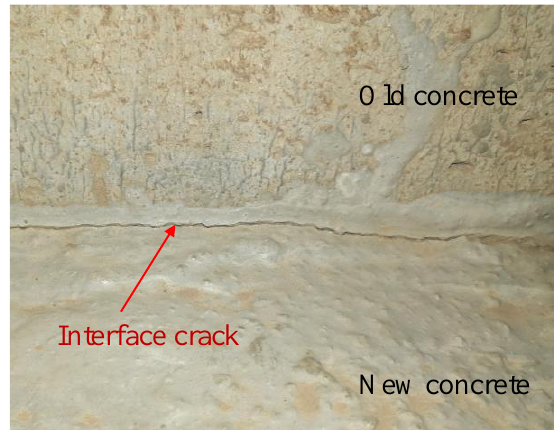
Figure 2. Interface crack of the new – old concrete.